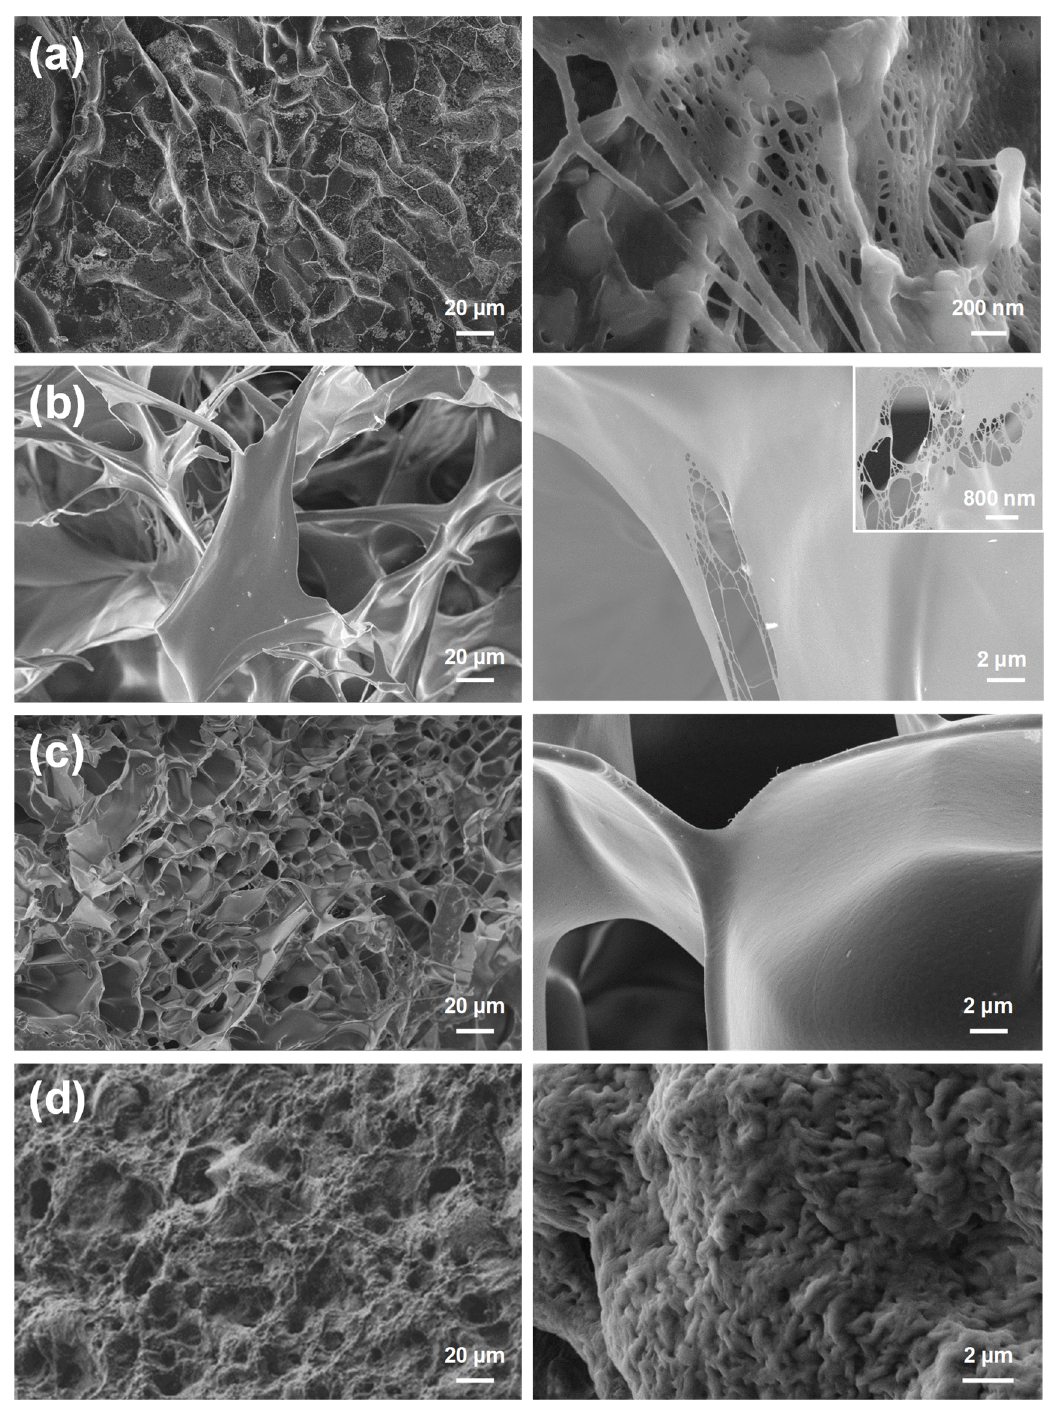
Figure 1. SEM micrographs of ( a ) κ C, ( b ) CMC, ( c ) PGGA and ( d ) PEA hydrogels: General view (low magnification images, left) and details (high magnification images, right).